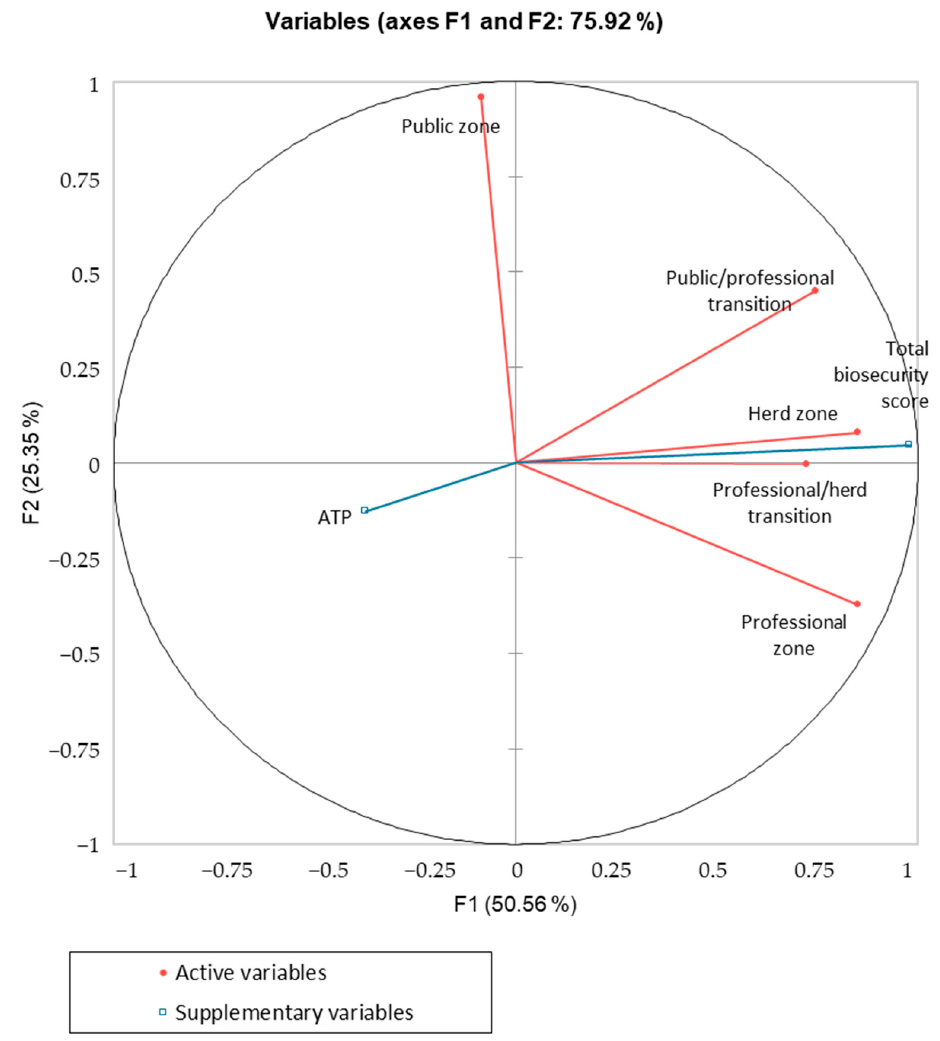
Figure 2. Correlation circle of PCA analysis. Active variables are changes in biosecurity scores in each zone after 12 months and are represented in red: public zone, public/professional transition, professional zone, professional/herd transition, and herd zone. Supplementary variables are repre- sented in